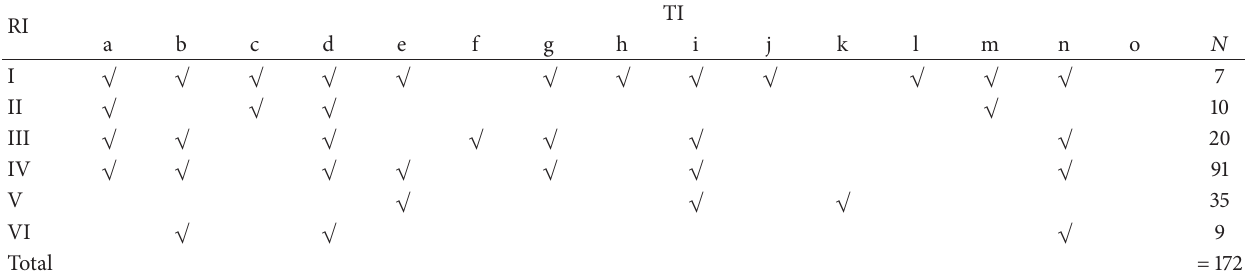
Table 4: Overall accident details in small construction sites.